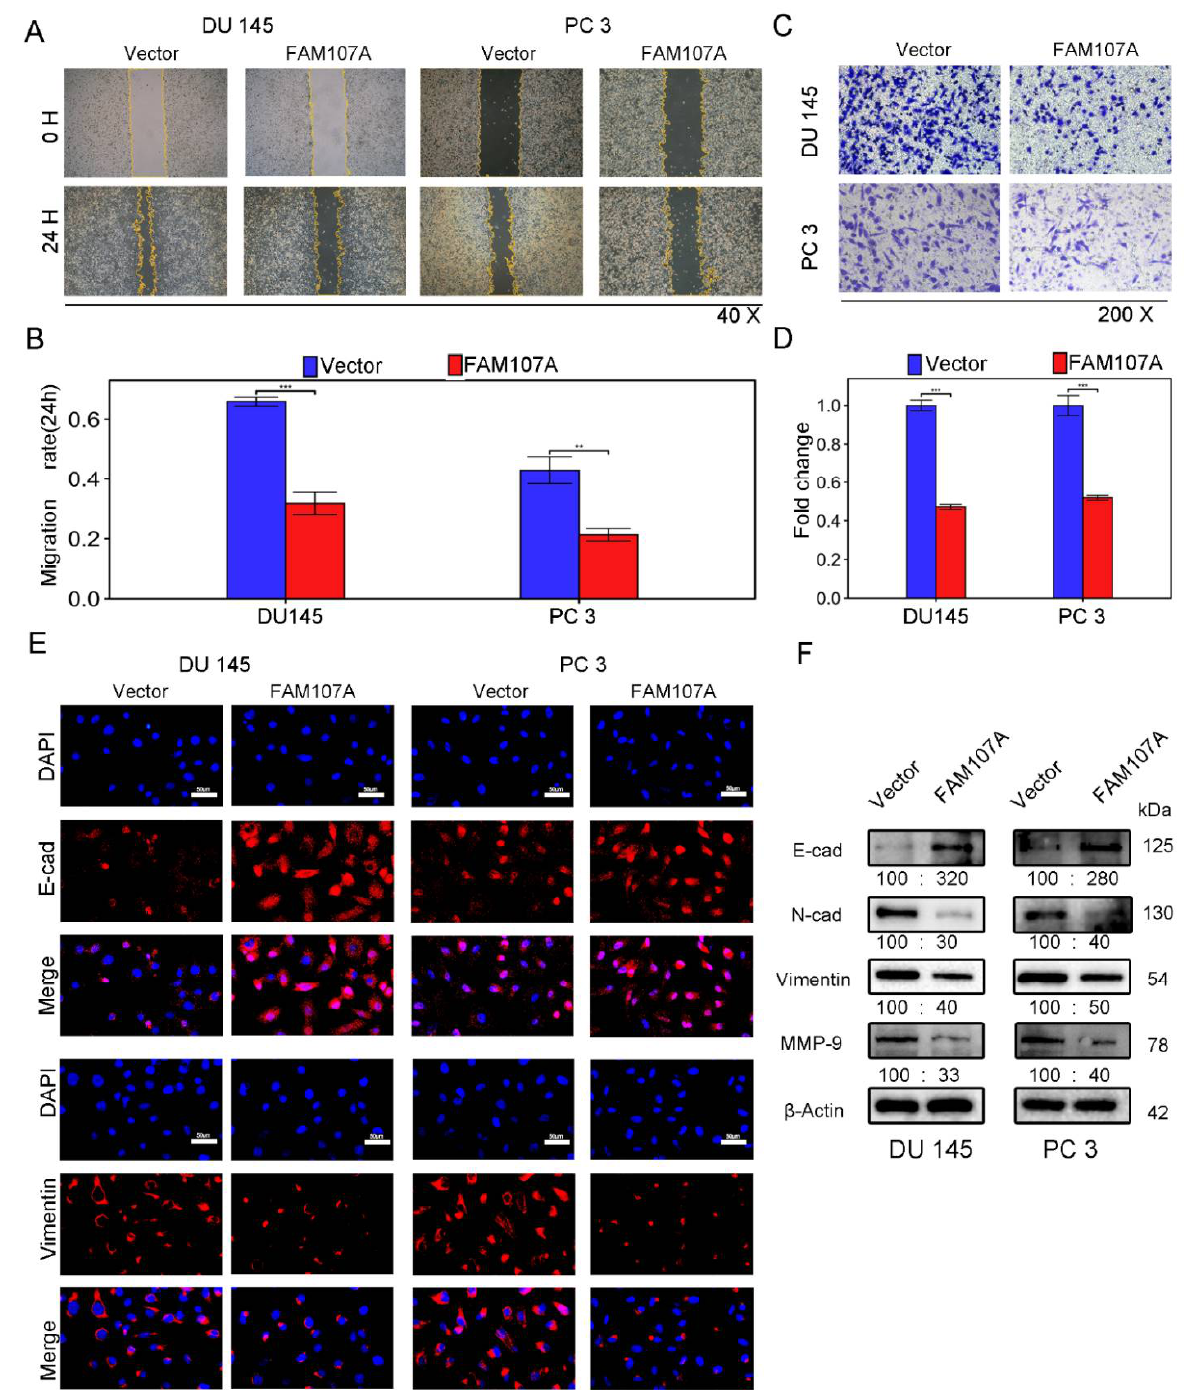
Figure 5. Overexpression of FAM107A inhibited PCa cell migration in vitro as well as invasion. ( A , B ) The migration ability of cells was assessed using a wound healing assay. The healing area of wounds was quantified by ImageJ software 24 h after wound formation. ( C , D ) Cell invasiveness was assessed using a Transwell invasion assay. The number of invaded PCa cells was quantified with ImageJ software. ( E ) Inhibition of EMT by overexpressed FAM107 was verified by Western blotting, and molecular weights are in kDa. ( F ) Immunofluorescence assays were performed to detect E-cad and Vimentin expression in cells at a magnification of 400 × . Data are expressed as the mean ± SD of at least three experiments. *** for p < 0.001, and ** for p <